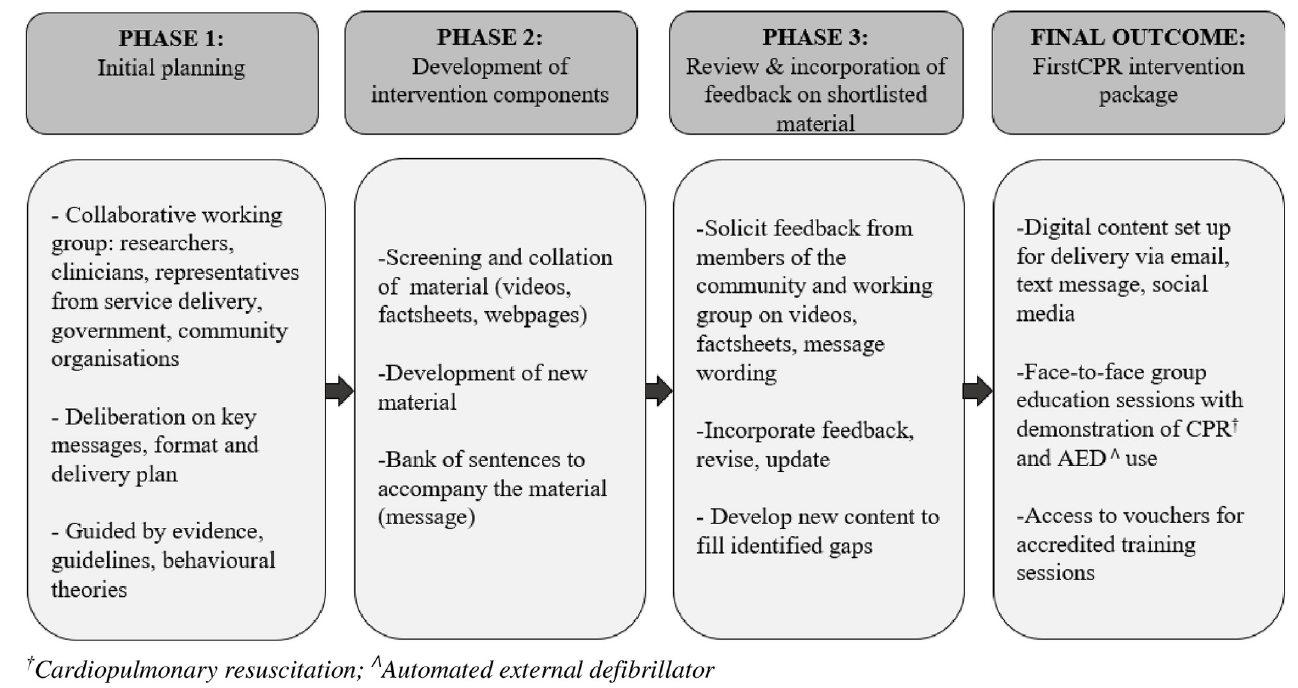
Fig 2. Summary of intervention development